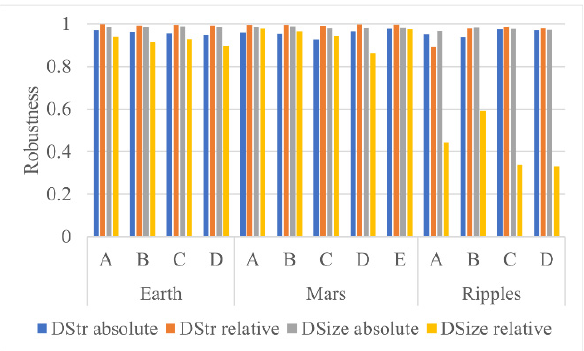
Figure 4. Images with high edge gradient. The absolute and relative robustness of DStr and DSize is averaged over binarization thresholds.